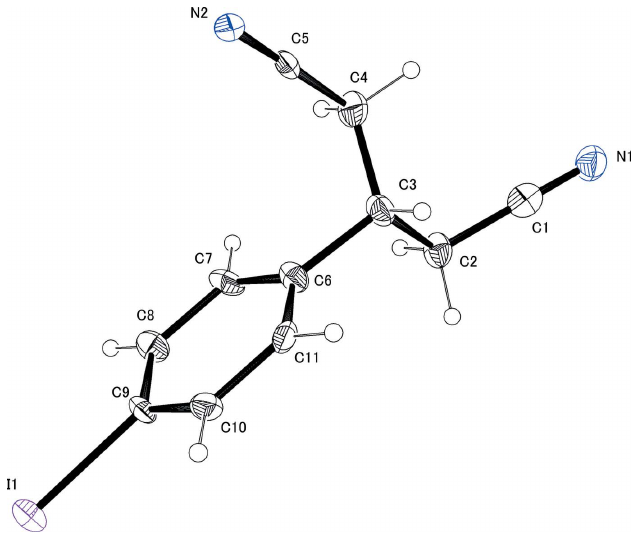
Figure 1 The molecular structure of the title compound with displacement ellipsoids drawn at the 50% probability level, with H atoms shown as small spheres.